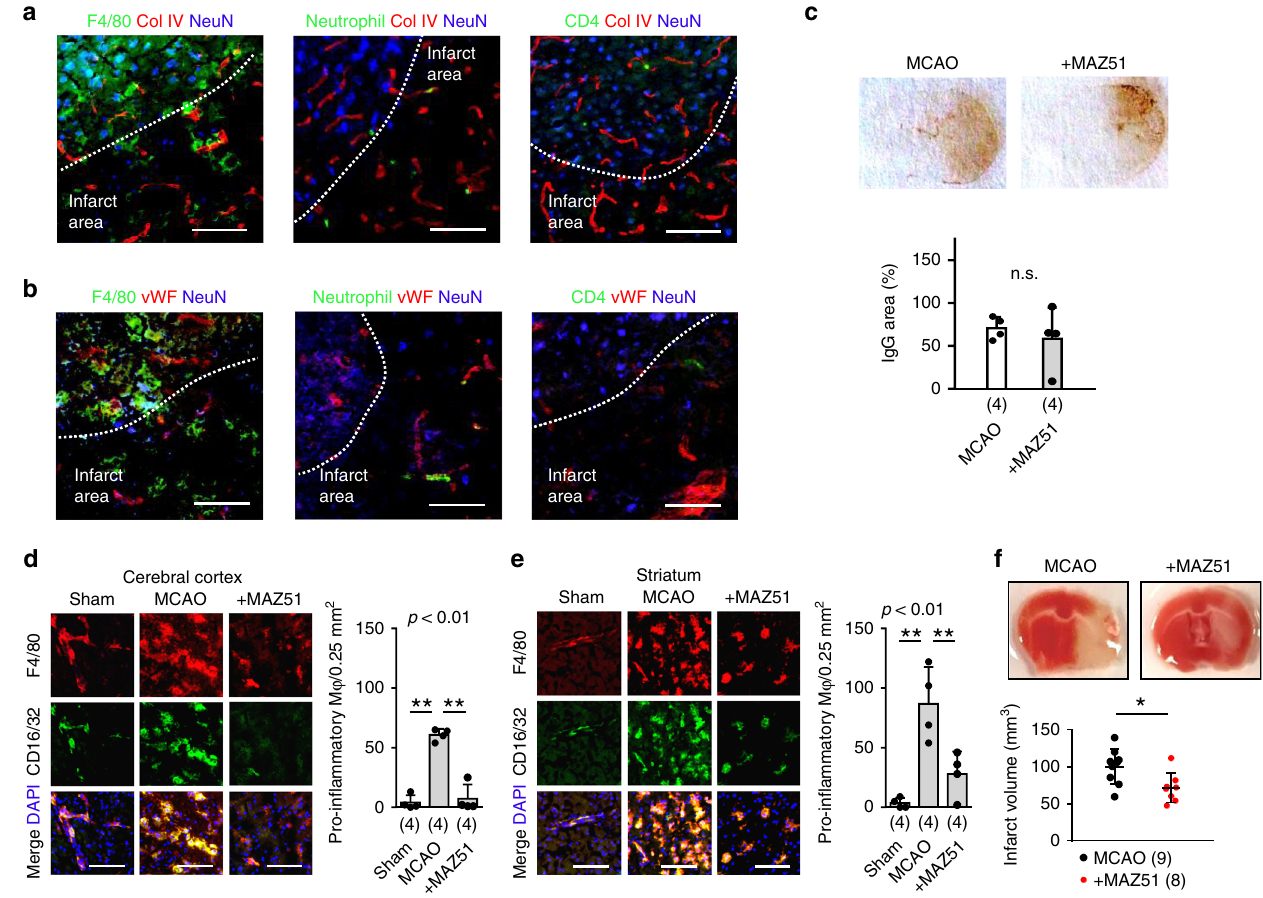
Fig. 6 Effects of blocking cervical lymphatic activation in brain infarct formation after stroke: a , b Male C57BL6 mice were subjected to transient focal ischemia. Neuronal staining with NeuN antibody and basal lamina staining with collagen IV (Col IV) antibody or endothelial staining with vWF antibody were conducted to provide visual landmarks for immune cell in fi ltration including monocytes/macrophages, neutrophils or T-cells. Immunohistochemistry con fi rmed that monocytes/macrophages and neutrophils were accumulated in the ischemic area and peri-infarct cortex. A few T-cells were in fi ltrated in the same area at 72 h after stroke. Scale: 100 nm. c The percentage of IgG leaked area after MCAO was assessed. MAZ51 treatment did not in fl uence IgG leakage after focal ischemia ( n = 4 biologically independent animals). unpaired t -test. d , e CD16/32 antibody was used to identify pro-in fl ammatory macrophage phenotype. At 72 h after focal ischemia, pro-in fl ammatory macrophages were accumulated in ipsilateral cortex ( d ) and striatum ( e ). Intranasal treatment with MAZ51 (3 ng/10 µ L) signi fi cantly reduced pro-in fl ammatory macrophages ( n = 4 biologically independent animals). Scale: 100 nm. ** P < 0.01, one-way ANOVA followed by Fisher ’ s LSD test. f MAZ51 (3 ng/10 µ L) signi fi cantly decreased cerebral infarction volumes at 72 h (MCAO; n = 8, MCAO + MAZ51; n = 9 biologically independent animals). Vehicle: 100.1 + / − 23.8 mm 3 , MAZ51: 71.2 + / − 19.7 mm 3 . * P < 0.05, unpaired t -test. All values are mean + / − PBS twice, sections were incubated with ABC reagent for 30min, followed by being washed with PBS for 10min, incubated with detection substrate for 10min. Infarct area after Nissl staining or IgG leaked area was calculated as the percentage over ipsilateral hemisphere by Image J software. CLN or ILN extraction . Under iso fl urane anesthesia the ventral neck area of mice were dissected and left and right super fi cial CLNs (cervical lymph nodes) were removed right before MCAO. As for ILN (inguinal lymph node) extraction, left and right ILNs were removed from the groin right before MCAO. Intracerebroventricular and intra-striatum administration . Evans Blue dye (2%) was injected into lateral ventricles and intra-striatum in normal male Sprague Dawley (SD) rat. The rats were positioned on a stereotaxic frame and a 23-g stainless steel guide cannula was implanted into the right lateral ventricle using the stereotaxic coordinates from the bregma: − 0.9mm caudal, 1.4 mm lateral and 3.8mm from the skull for i.c.v. injection and − 0.2mm caudal, 3.0 mm lateral and 6.0mm for intra-striatum injection. The same procedure was used to inject (i.c.v.) MAZ51 (50 ng/5 μ L) or respective vehicle (PBS) immediately after the stroke onset in a randomized fashion. In normal male C57BL6 mice Evans Blue dye was injected into lateral ventricles or striatum at the following stereotaxic coordinates: i.c.v − 0.5mm caudal, 0.8mm lateral, 2.5mm deep. Striatum 0 mm caudal, 2.0mm lateral, 3.5mm deep.